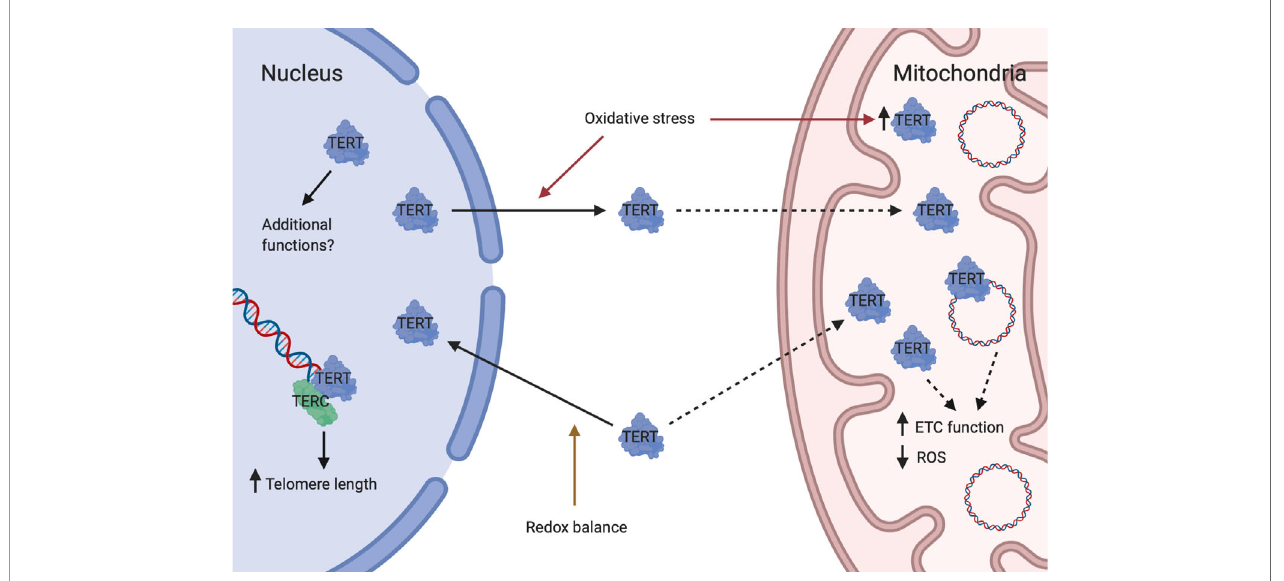
FIGURE 1 | Dual roles of telomerase reverse transcriptase. Under conditions of redox balance, TERT is mainly transported to the nucleus where it complexes with TERC to form telomerase which lengthen telomeres. Nuclear TERT may also have additional functions. In response to oxidative stress, TERT is exported from the nucleus and mitochondrial TERT is concomitantly increased. Whether this is due to direct shuttling from the nucleus to mitochondria or a result of increased import of newly synthesized TERT into mitochondria is currently unknown. In mitochondria, TERT binds to and protects mtDNA and may perform additional actions. Mitochondrial TERT is associated with improved ETC function and reduced ROS generation. Created with